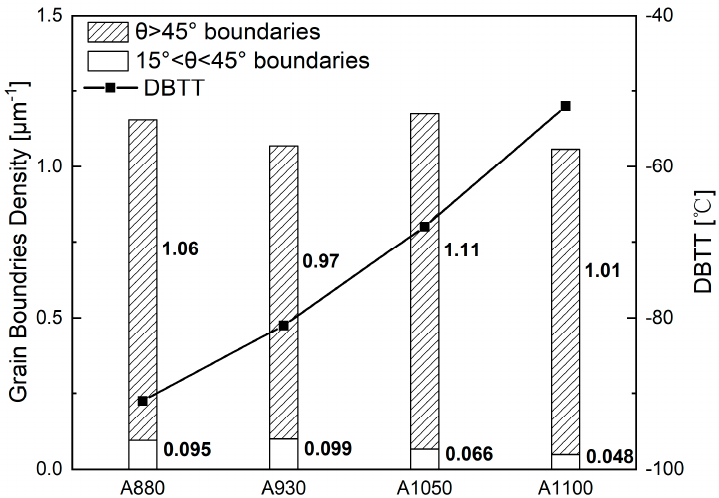
Figure 7. Grain boundary density (15° < θ < 45° and θ > 45°) and DBTT of experimental steels.